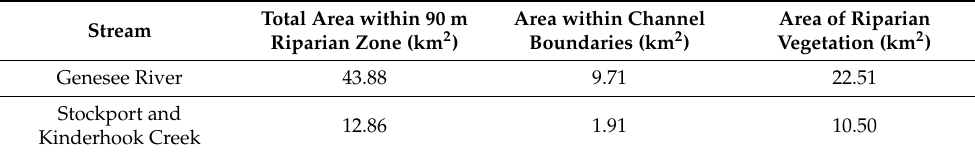
Figure 4. Example of classified riparian vegetation overlaid with manually classified reference points. Background image is 2015 NAIP. Center of map is located near Town of Chatham, New York State, United States. Table 1. Summary of area within the channel and covered by riparian vegetation for the Genesee River and Stockport and Kinderhook Creek